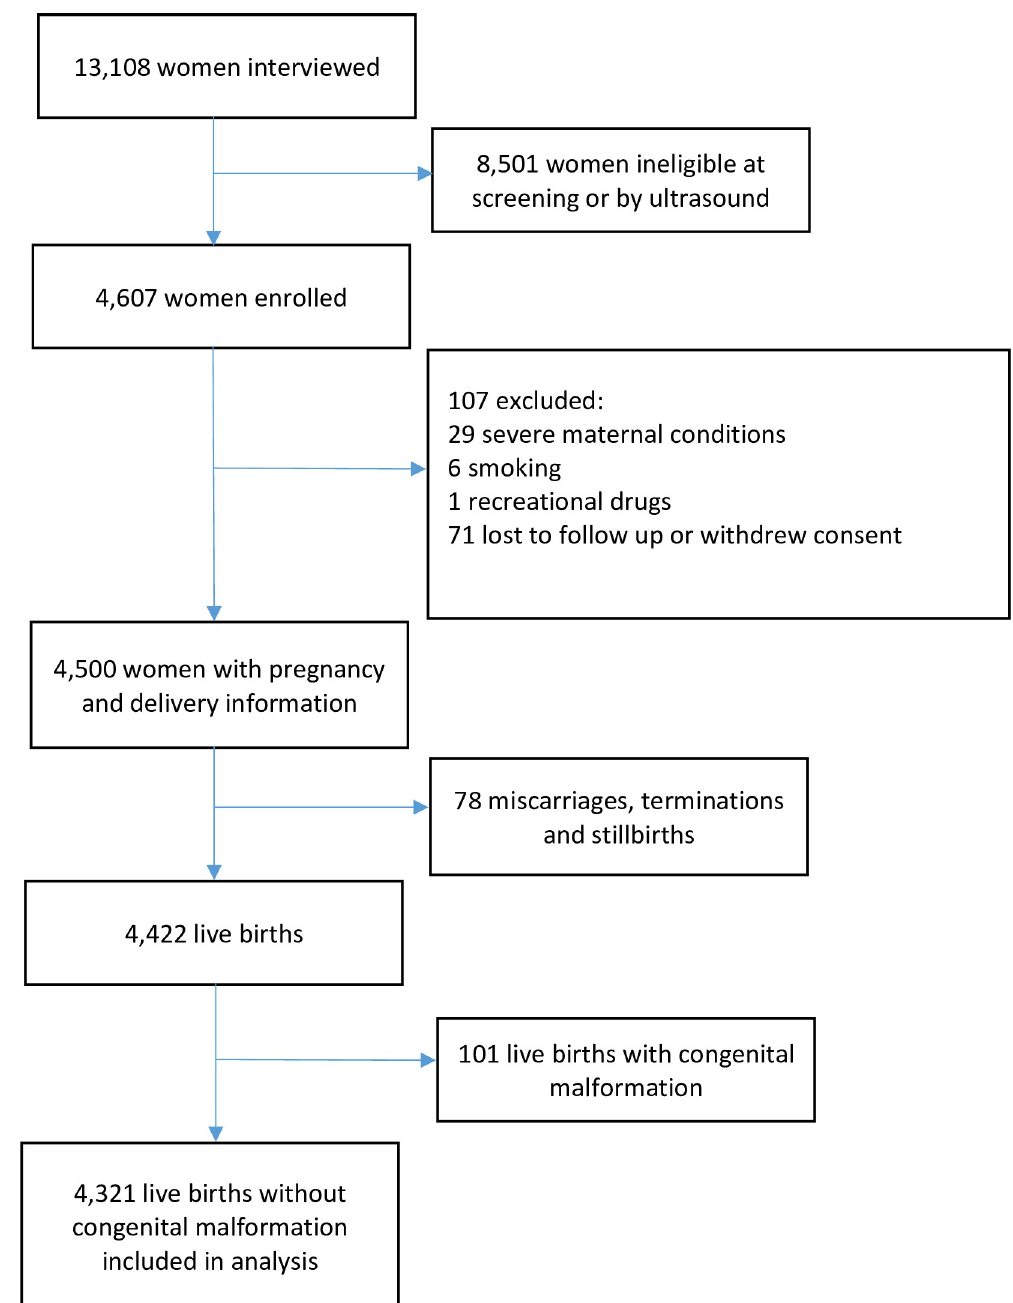
Fig 1. Flow diagram illustrating women enrolled in FGLS. FGLS, Fetal Growth Longitudinal Study.